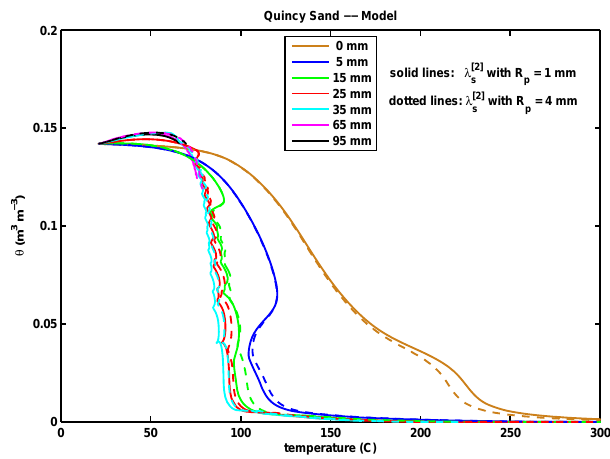
Figure 4. Modeled soil moisture contents vs modeled soil temper- atures for the Quincy Sand heating experiment (see Figs. 1 and 2 above). The solid lines are for a model simulation with R p = 1mm; the dotted lines correspond to a simulation with R p = 4mm. This is the solution space representation of the model’s solutions, which are to be compared with the observations shown in the preceding figure, Fig. 3, as well as with the equilibrium model results shown in Fig. 5 of Massman (2012).